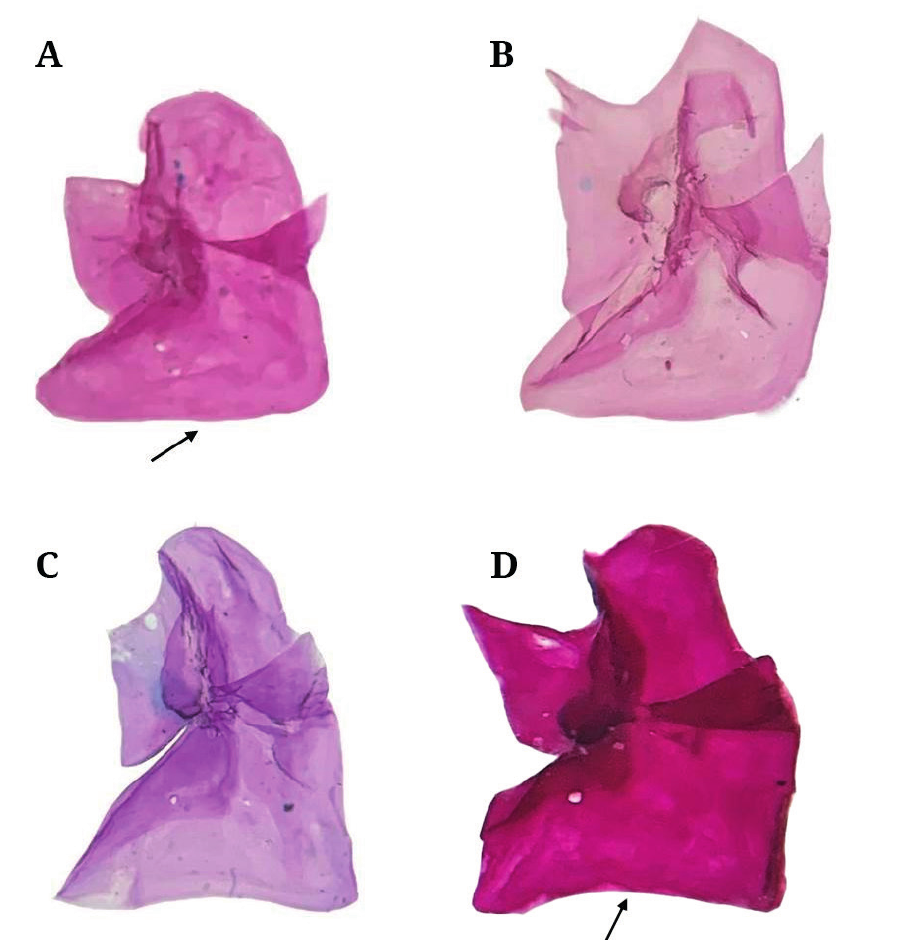
FIGURE 4 | Ventral view of left lacrimal. A. Tlaloc portillorum (MZ-UNICACH 7222, 70.5 mm SL); B. T. hildebrandi (MZ-UNICACH 2266, 75.1 mm SL); C. Profundulus mixtlanensis (MZ-UNICACH 6716, 55.6 mm SL); and D. P. punctatus (MZ-UNICACH 6632, 67.3 mm SL). Arrow point to ventral margin of the